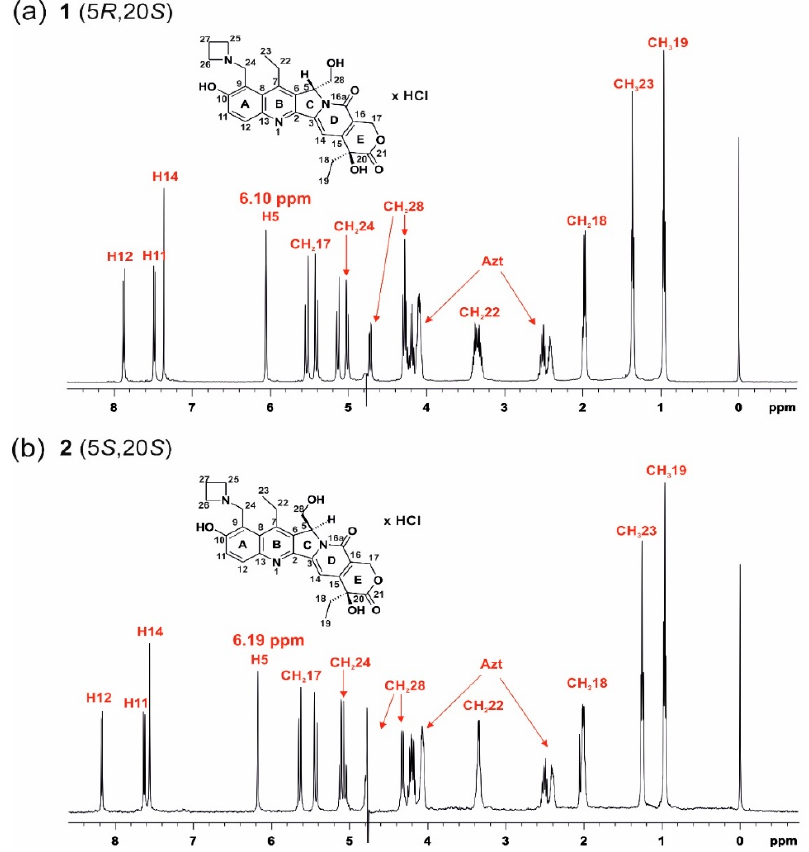
Figure 1. The 1 H NMR spectra of diastereomers: ( a ) 1 and ( b ) 2 in D 2 O solution, pH 5, temp. 25 ◦